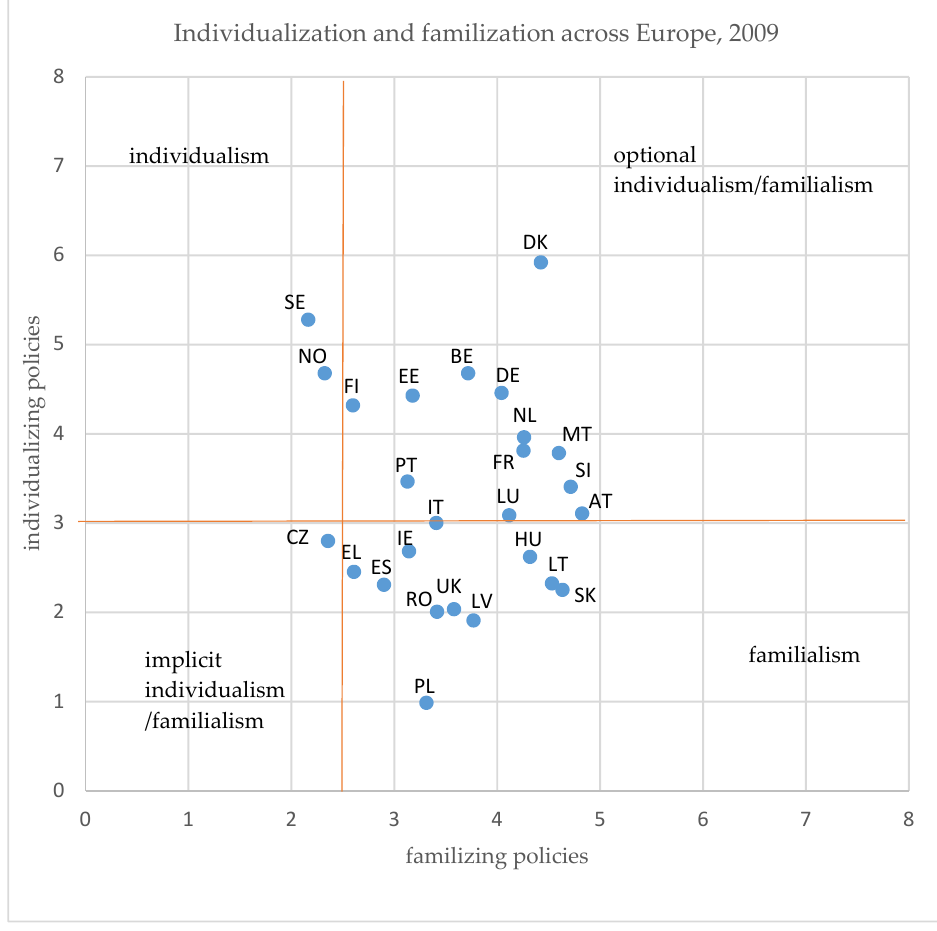
Figure 1. European countries according to the individualizing and familizing policy indices, 2009.